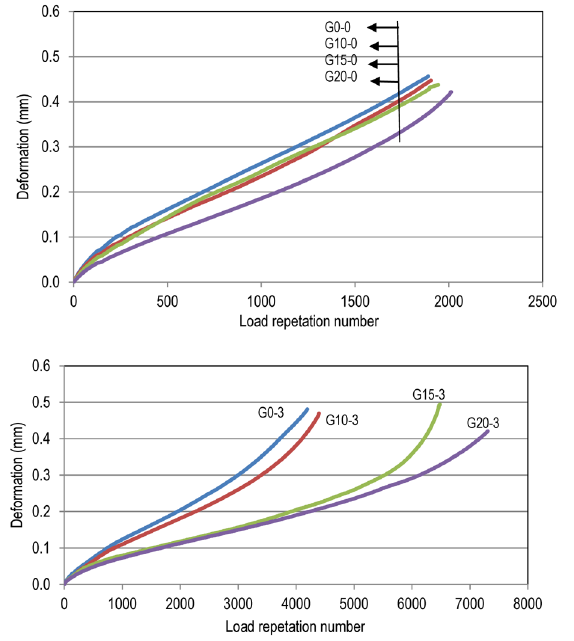
Fig. 11. The load repetition number-deformation relation of the mixtures